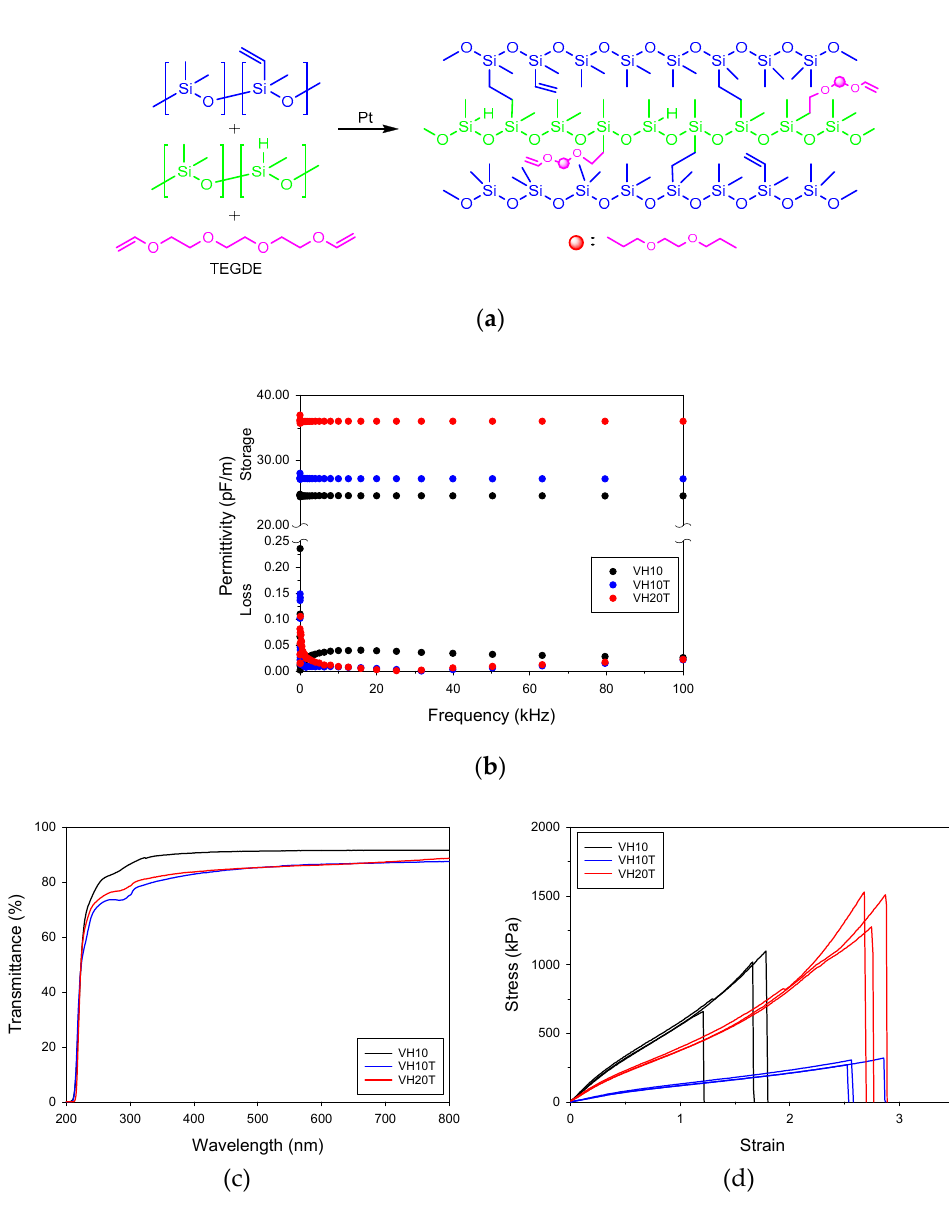
Figure 2. Schematically expressed reaction of TEGDE with HPDMS during crosslinking between VPDMS and HPDMS ( a ). Storage permittivity ( b ), transmittance ( c ), and stress–strain curves ( d ) of the crosslinked films fabricated from VH10, VH10T, and VH20T polymer dopes, respectively.